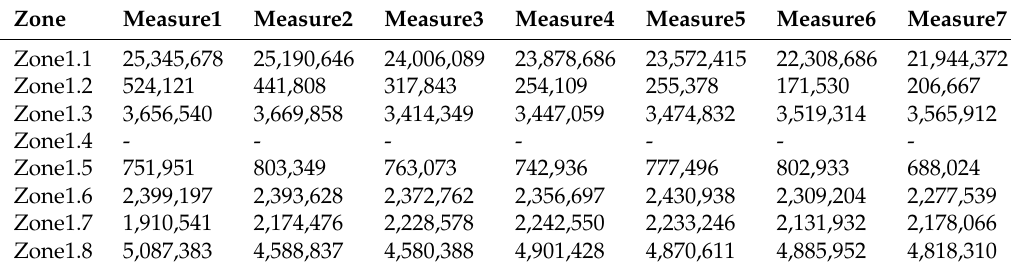
Table 3. Data source information as plain text.